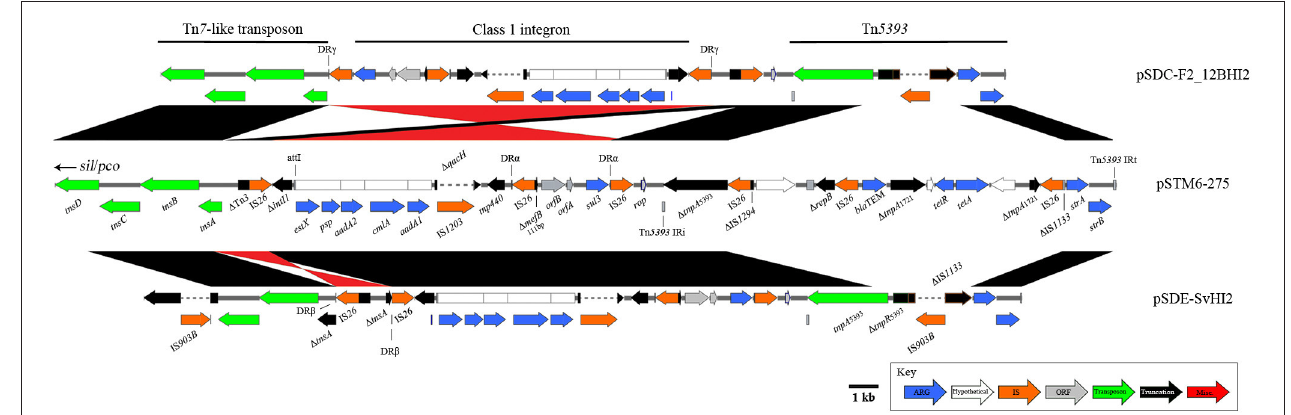
FIGURE 4 | Diagrams and comparisons of sul3- associated resistance structures carrying an IS 26 truncated intI1 Structural comparisons between related sul3 encoding regions, comprising a putative transposon, sul3 -CS integron and Tn 5393 . Alignments in black show homology, with inversions indicated in red. Plasmids pSDE-SvHI2 (bottom) and pSDC-F2_12BHI2 (top) both show further rearrangement compared to the more recent pSTM6-275 structure.